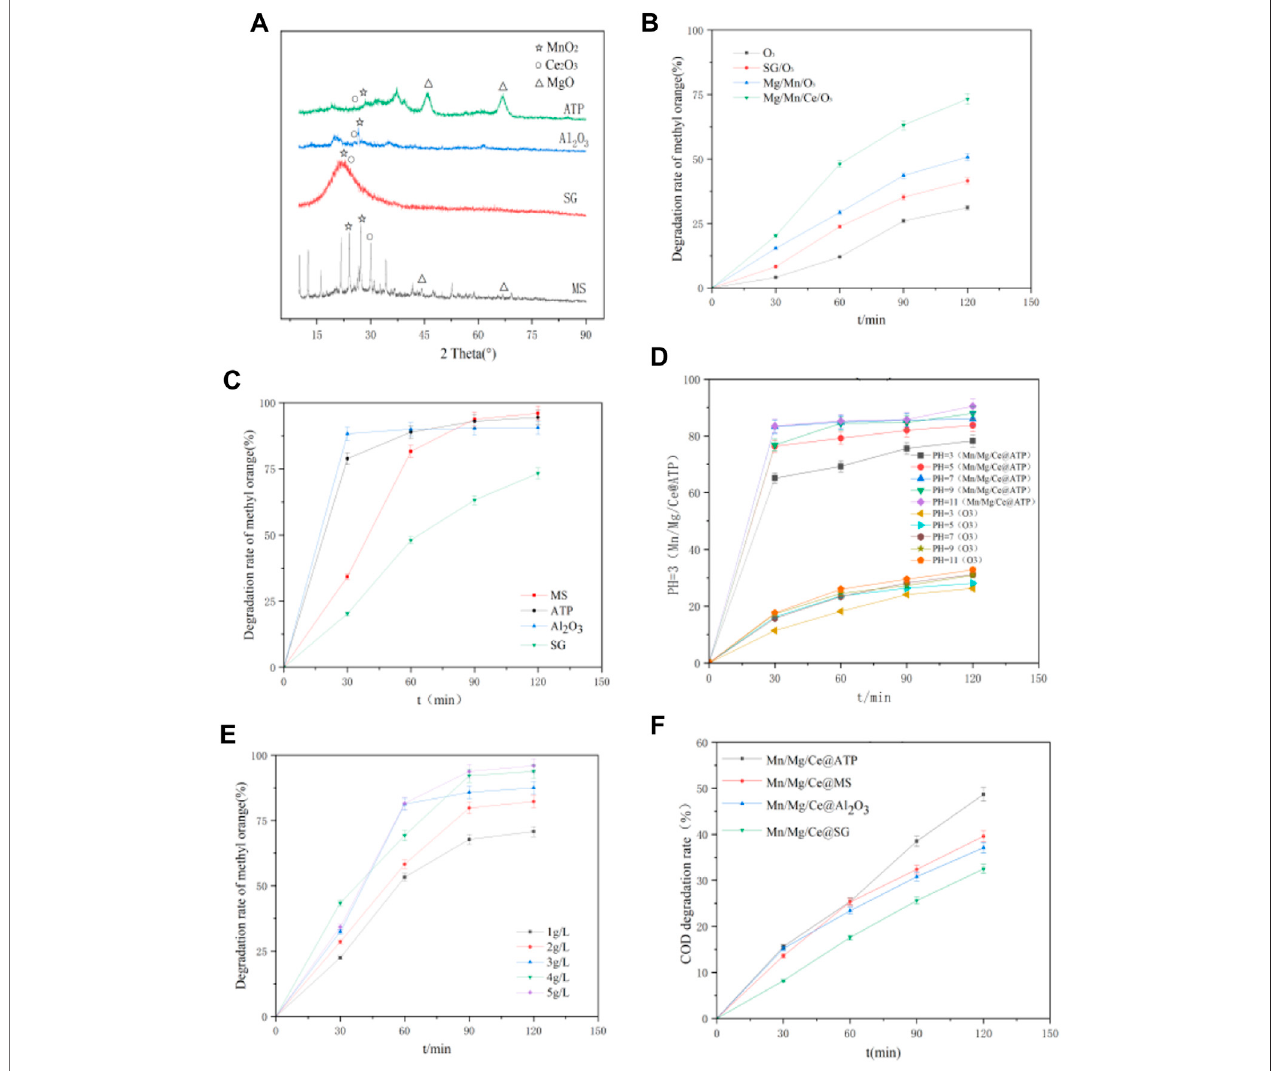
FIGURE2|(A) XRDspectrum offourcatalysts. Effectsof (B) impregnationsolution, (C) carrier, (D) pH,and (E) catalystdosageoncatalytic performance. (F) COD degradation rate of the four catalysts with different supports for red powder wastewater